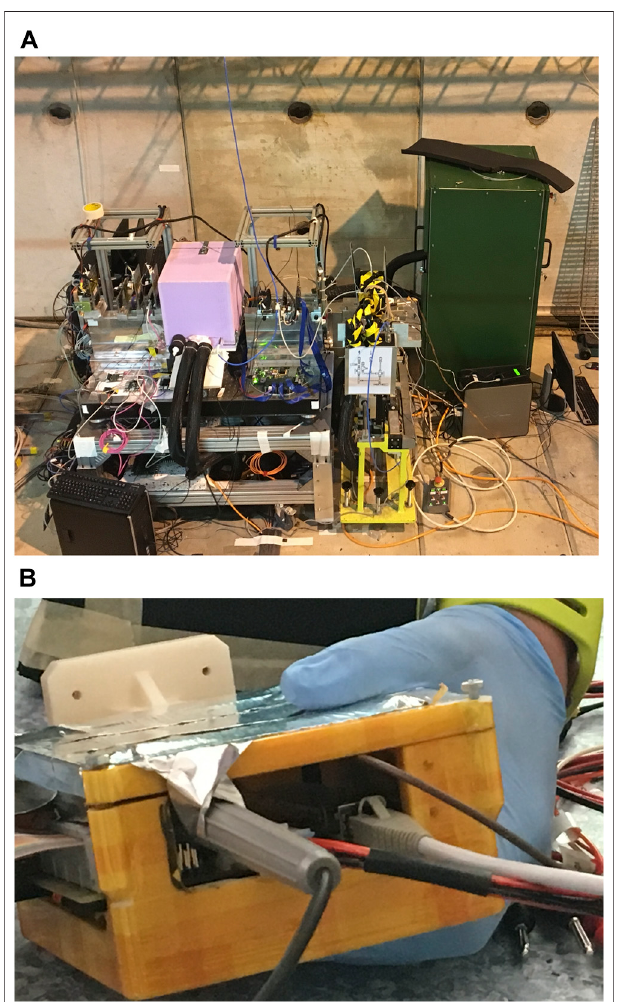
FIGURE 10 | 3D sensor response to the 300 GeV pion beam after irradiation at − 22 ° C. (A) Beam pro fi le where the sharp transition above 250 in the vertical direction is due to bean misalignment and (B) correlation curve of the x coordinate of the DUT and the one of the x coordinate of the fi rst FE-I4 telescope